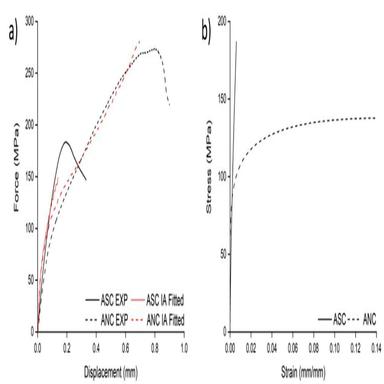
Results of the inverse analysis on copper: (a) force-displacement and (b) predicted engineering stress–strain curves.